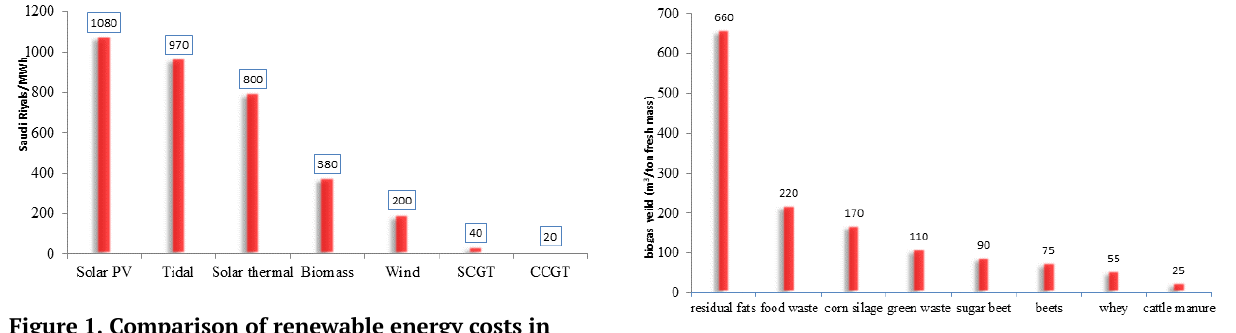
Figure 2. Biogas production from various